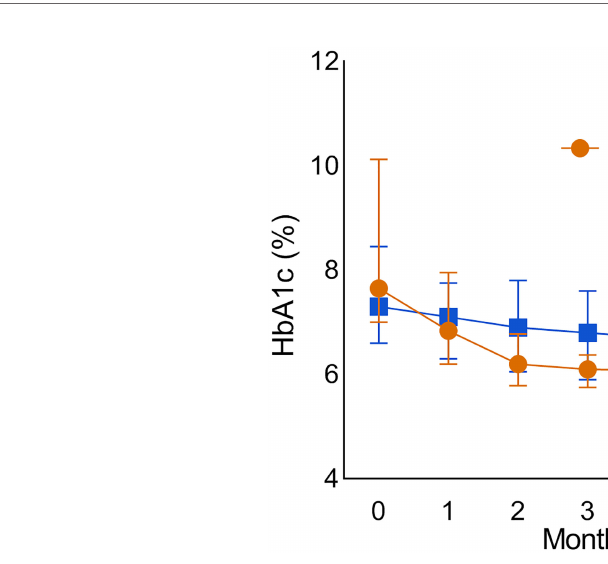
FIGURE 3 | The fold line diagram which describes the changing trends of the HbA1c in the two groups during the intervention. LCD, Low-carbohydrate diet; LFD, Low-fat diet; HbA1c, glycosylated